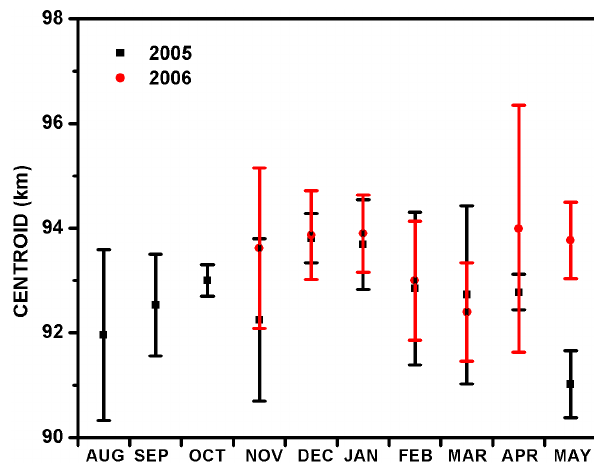
Fig. 7b. Same as Fig. 7a, but for Centroid height.